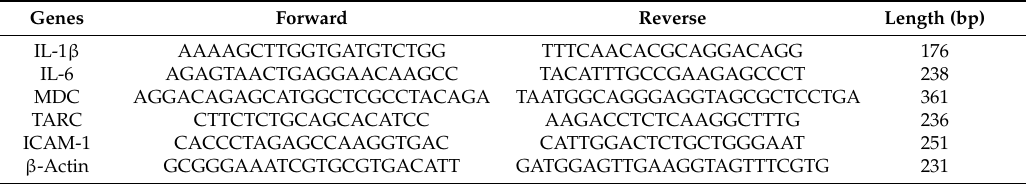
Table 1. Reverse Transcription-Polymerase Chain Reaction (RT-PCR) primer